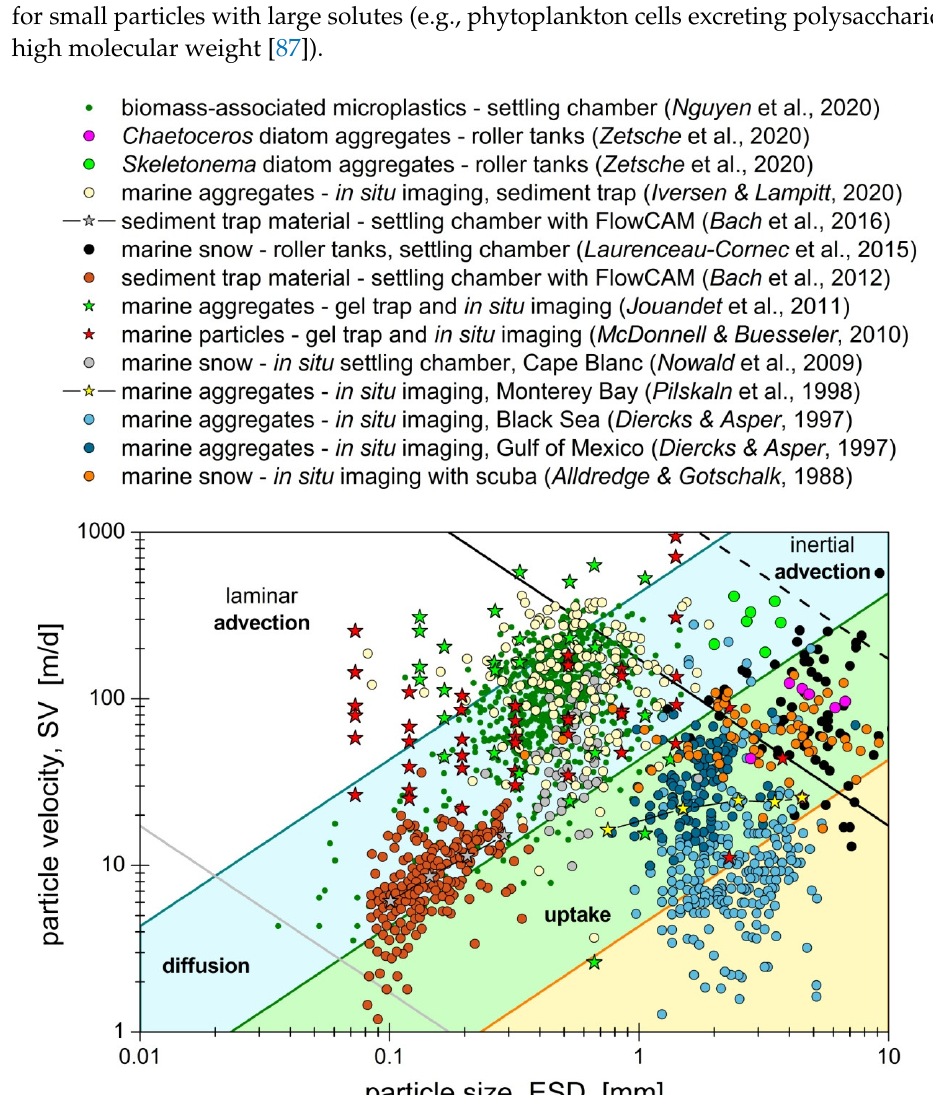
Figure 8. Phase diagram in the velocity–size space delineating the domain of prevalence for the fundamental transport processes that shape the nutrient field around sinking marine aggregates. The symbols represent experimental data for the sinking velocity (SV) and the equivalent sphere diameter (ESD) of individual aggregates (circles) or populations of aggregates (stars). The lines represent theoretical boundaries established by timescale conditions. The black lines correspond to Re = 1 (solid) and Re = 10 (dashed), with a kinematic viscosity of 𝜇(cid:3556) (cid:3100) 𝜌(cid:3556) (cid:3100) ⁄ = 10 (cid:2879)(cid:2870) 𝑐𝑚 (cid:2870) /𝑠 for seawater. The solid grey line corresponds to Pe = 1 with 𝐷(cid:3561) (cid:3002)(cid:3100) = 10 (cid:2879)(cid:2873) 𝑐𝑚 (cid:2870) /𝑠 . The colored lines correspond to Pe/Da=100 with uptake timescale 𝜏̃ (cid:3022) = 10𝑠 for dark cyan, 𝜏̃ (cid:3022) = 100𝑠 for dark green, and 𝜏̃ (cid:3022) = 1000𝑠 for orange. The plume lifetime is in the range of >1000 s in the yellow-shaded area, 100 − 1000 s in the green-shaded area, 10–100 s in the cyan-shaded area, and <10 s in the non-shaded area. Microbial uptake and plume quenching are important for data falling in the green-yellow areas, modest in the cyan area, and negligible in the non-shaded area. Figure citations: [22,86–97].